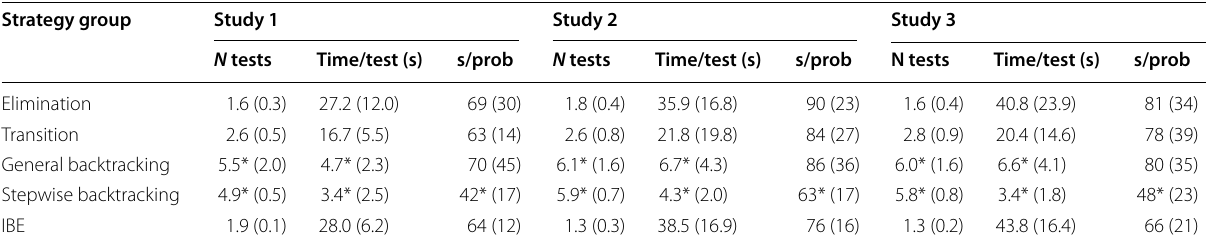
Table 7 Mean performance on the fault diagnosis task per problem by strategy group. Standard deviations in